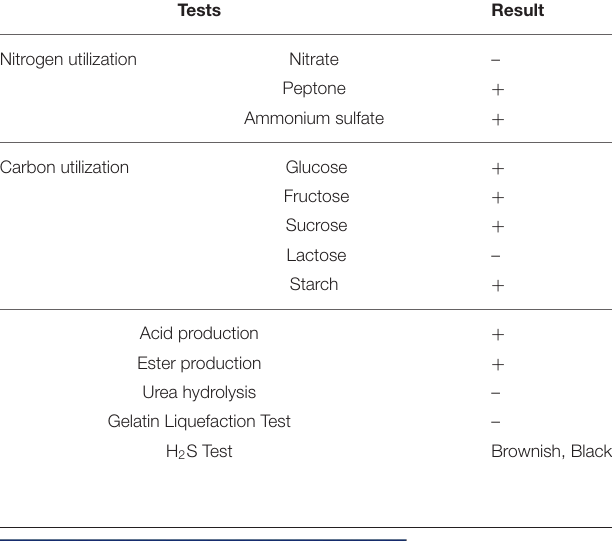
TABLE 1 | Biochemical characteristics of the S. boulardii strain.